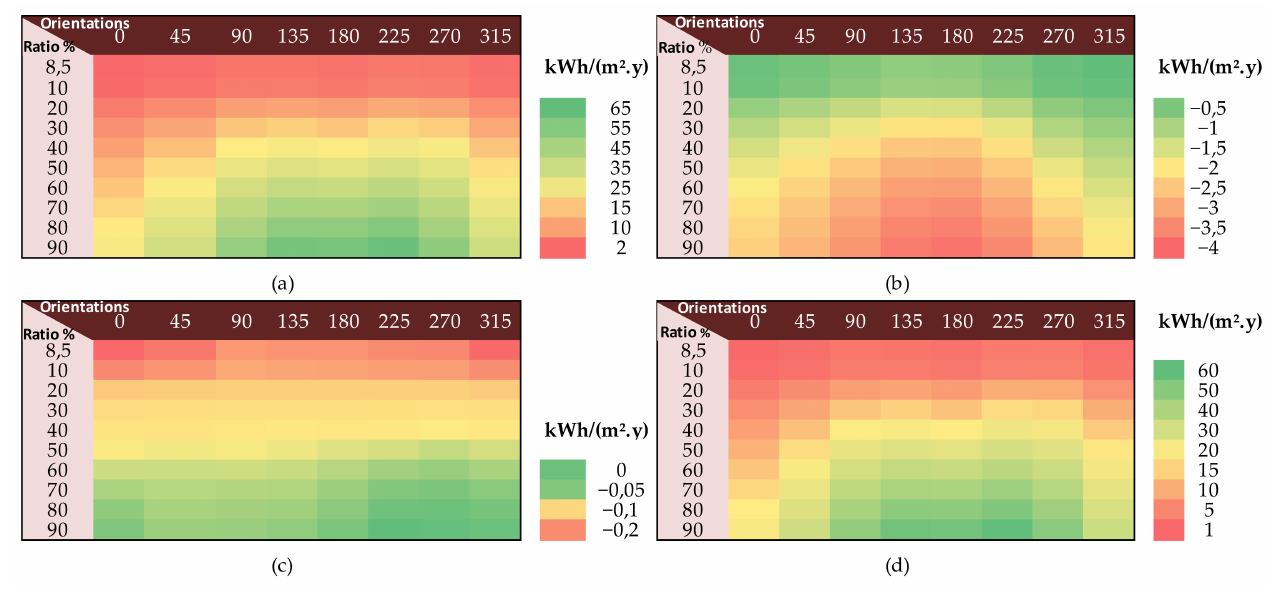
Figure 6. Variation in energy demand resulting from use of EC glazing instead of double glazing window, as a function of WWR and orientations for ( a ) cooling. ( b ) Heating. ( c ) Lighting. ( d ) Overall consumption. per unit area kWh/(m 2 .y).